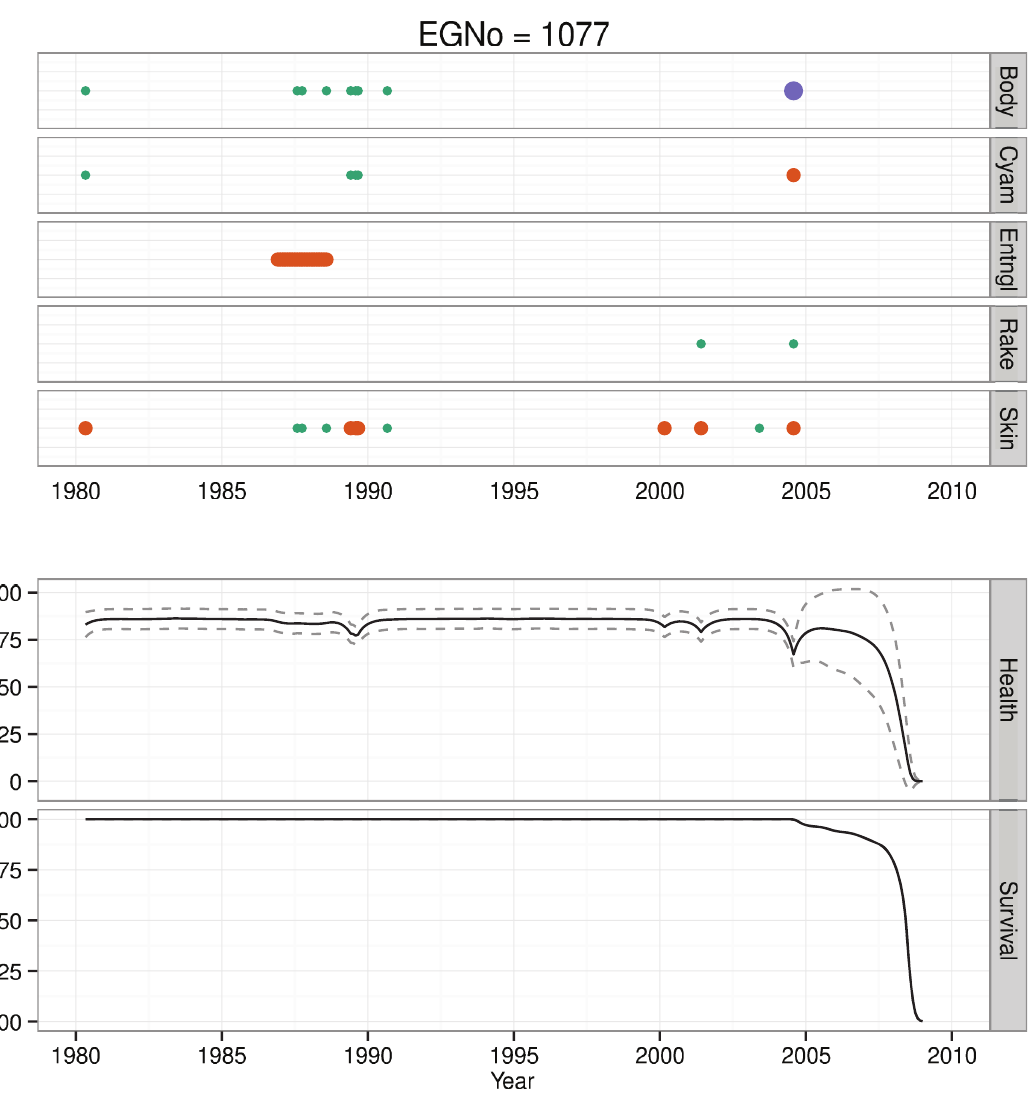
Figure 11. Health time series for whale # 1077. # 1077 has not been seen since 2004. At the time of the last sighting its health status was poor. Estimates of health since the last sighting have declined to 0, and the animal is currently presumed to be dead.